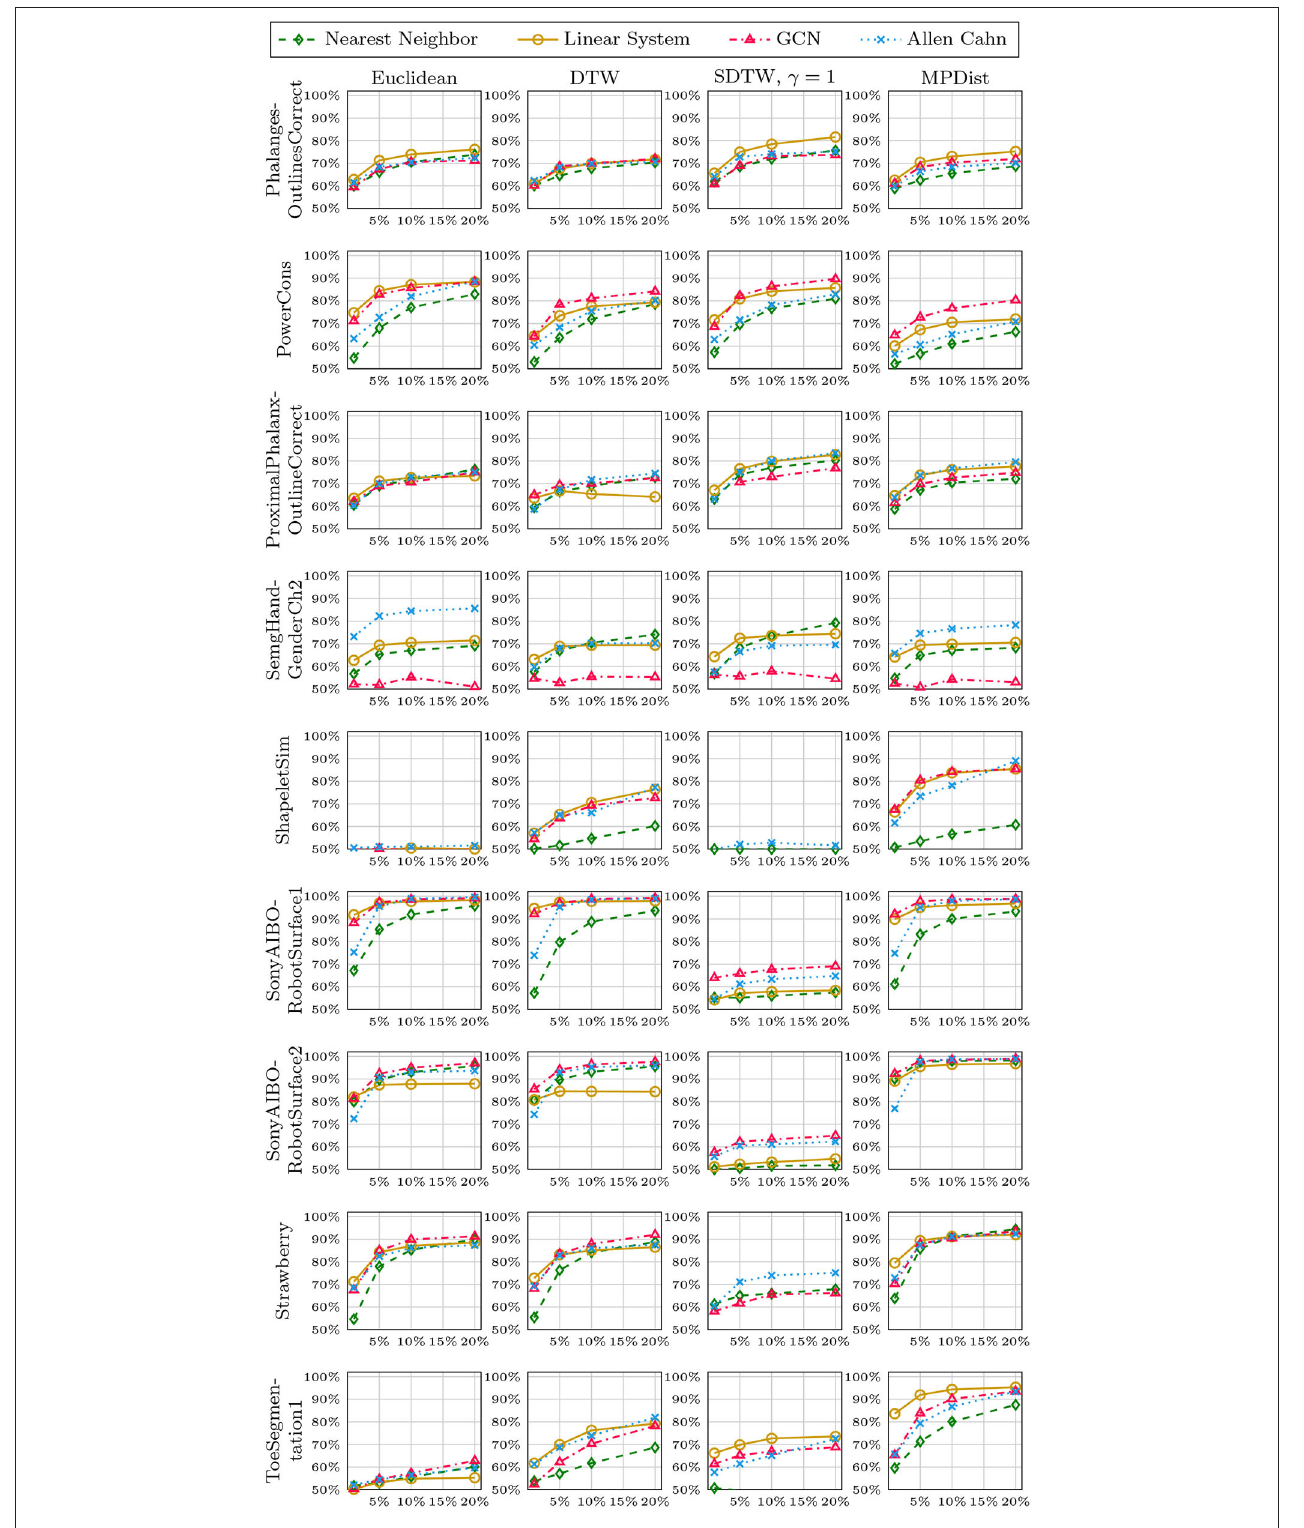
FIGURE 11 | Method accuracy comparison for random training splits of different sizes (part